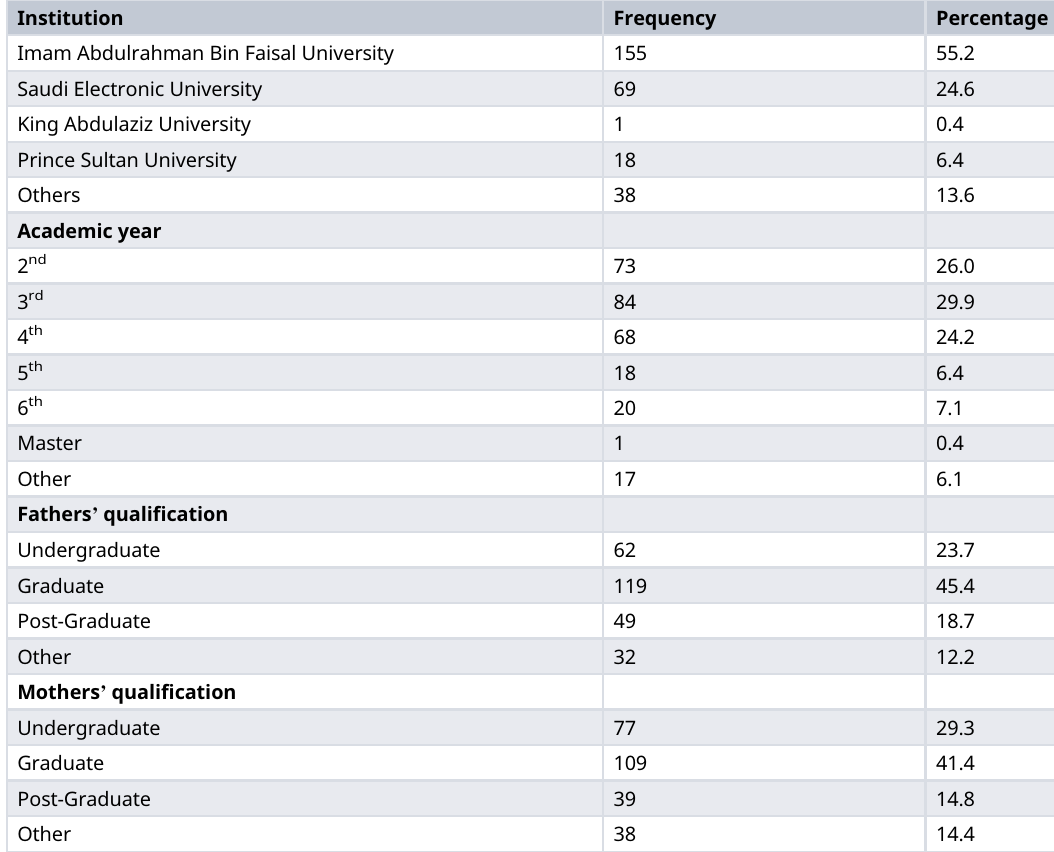
Table 1. Categorization of participating students according to